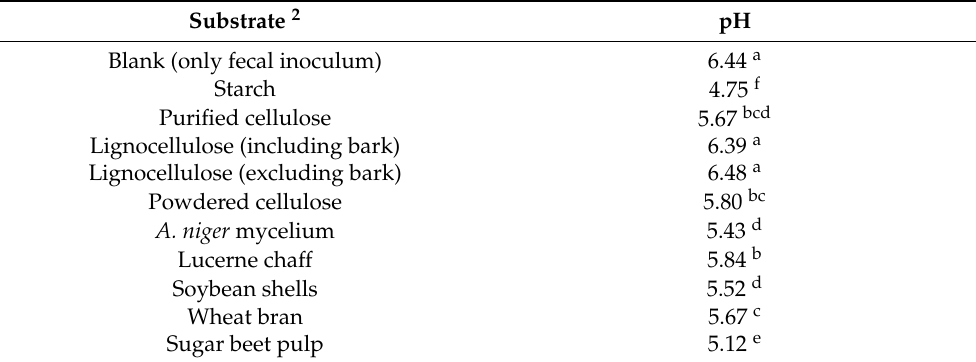
Table 6. Least squares means of post-incubation pH-values 1